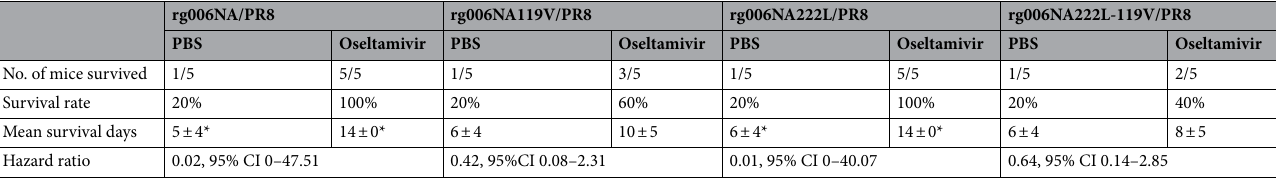
Table 3. Survival of mice in drug or non-drug groups. * P <